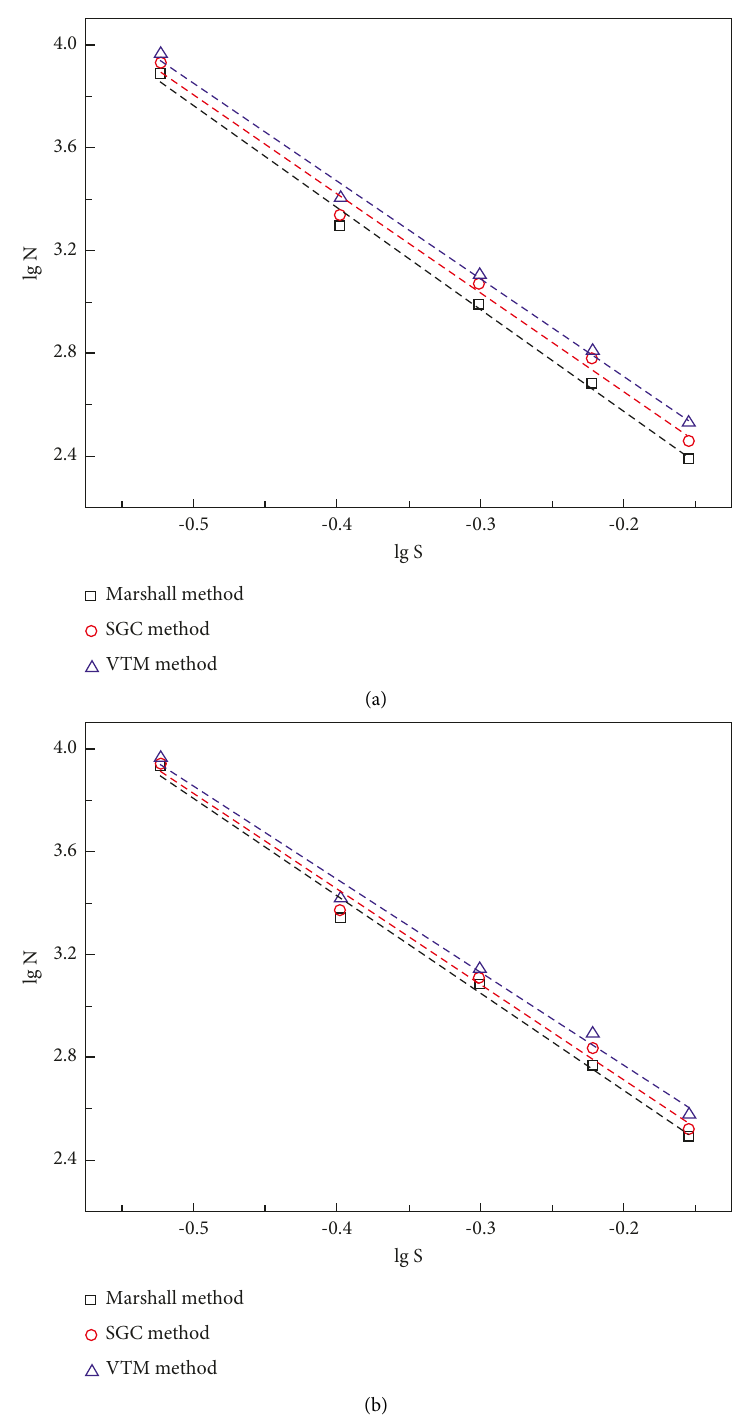
Figure 11: Fatigue curve of the SMA-13 mixture with different compaction methods. (a) Specification gradation. (b) Skeleton dense